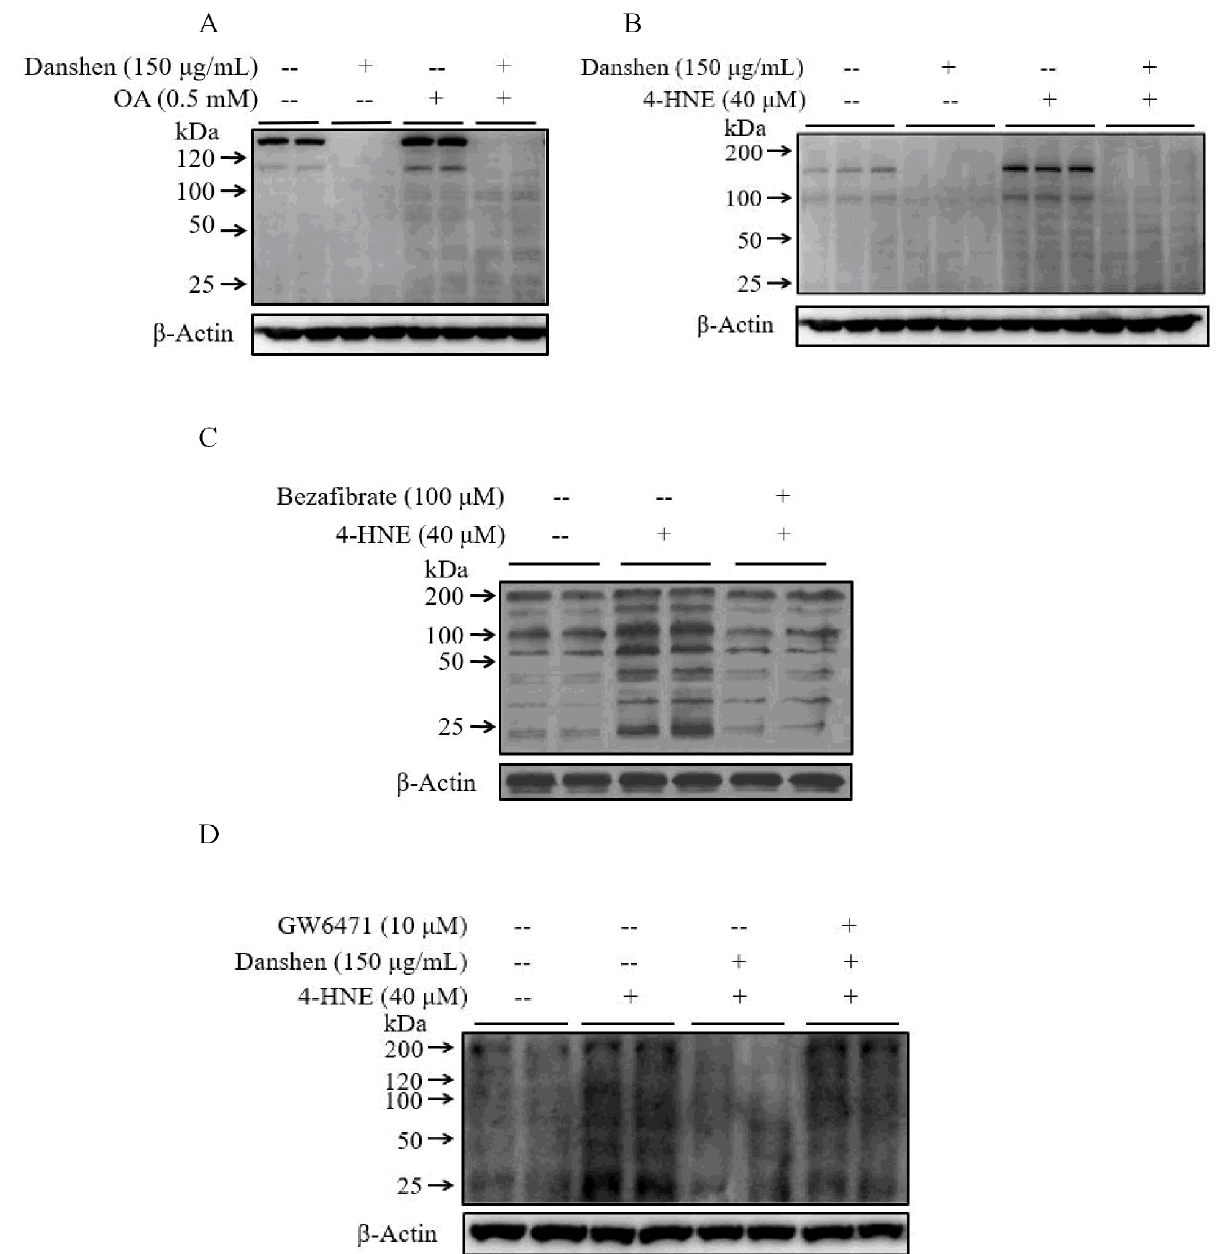
Fig 6. Danshen promotes the catabolism of 4-HNE via activating PPAR α . A & B . Danshensignificantly reduces the intracellular4-HNE accumulationafter exogenous 4-HNE or OA exposure. NCTC1469cells are pretreatedwith 150 μ g/mLDanshenfor 2 hours before 4-HNE or OA addition. Cell lysates were collected8 hours later for Western Blotting analysis. C . Bezafibrate,PPAR α agonists, significantly decreased the intracellular4-HNE accumulationafter exogenous4-HNE exposure. HepG2 cells are pretreatedwith 100 μ M bezafibratefor 1 hour before 4-HNE exposure.Cell lysates were collected8 hours later for Western Blotting analysis. D . GW6471, PPAR α antagonist, significantly increasedthe intracellular4-HNE accumulationafter exogenous 4-HNE exposurewhich has been decreased after Danshenaddition. HepG2 cells are pretreatedwith GW6471 for 1 hour, then Danshenwas treated 2 hours before 4-HNE exposure. Cell lysates were collected 8 hours later for Western Blotting analysis.